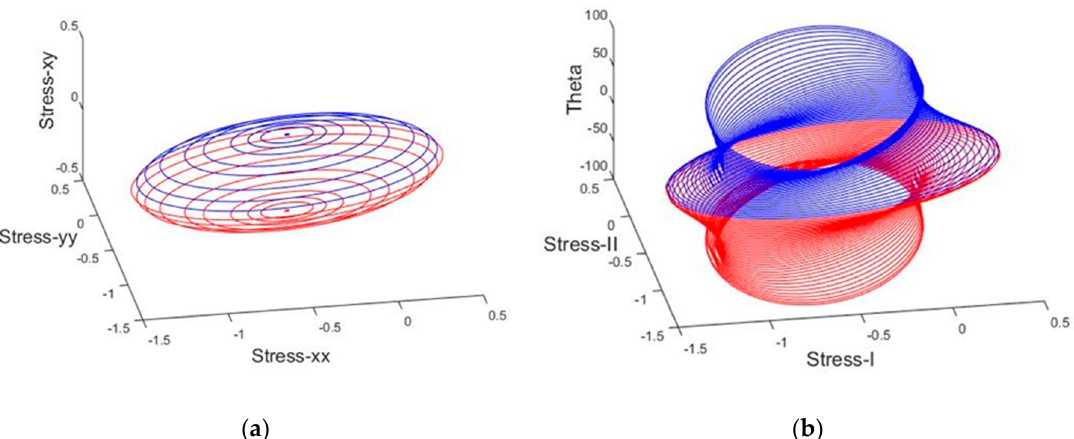
Figure 10. Dimensionless failure surface of masonry material using the simplified failure criterion: ( a ) non-dimensionless normal stress terms; and ( b ) non-dimensionless Principal stress terms.